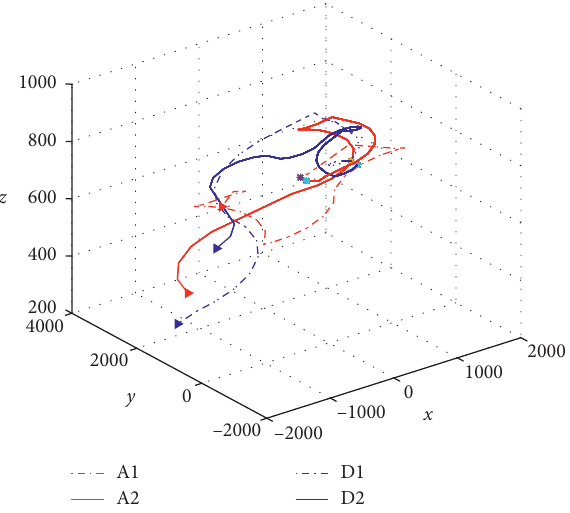
Figure 8: Multi-UUV cooperative dynamic maneuver decision-making: stage 5. Table 3: Calculated optimal mix strategy of “A”: stage 1.